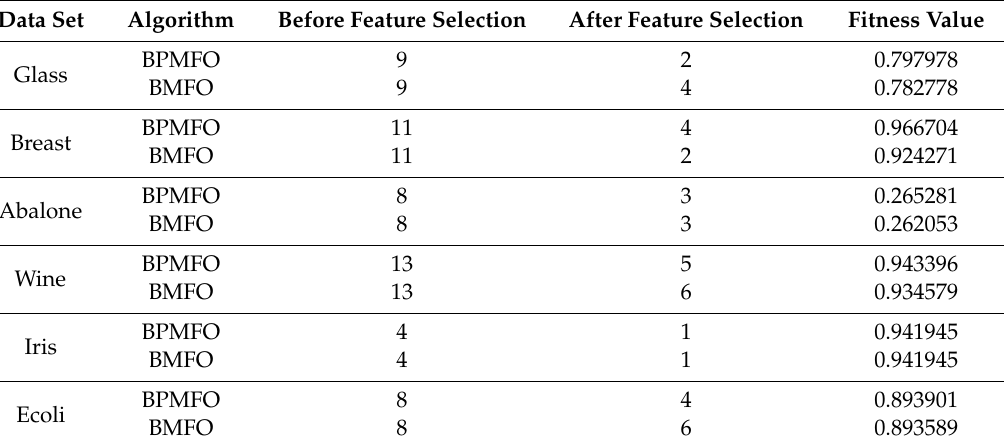
Table 11. Comparison results of UCI data sets.